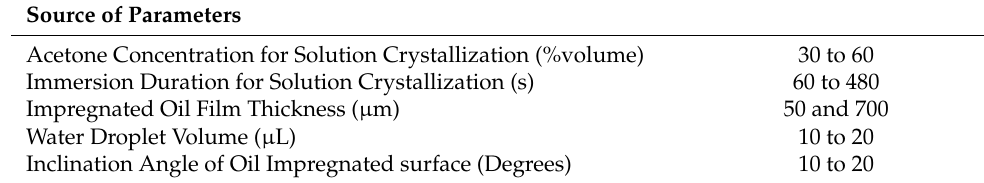
Table 1. Parameters used in solution crystallization and dust mitigation from oil impregnated surfaces. In the experiments, four concentrations of acetone solution and four levels of immersion are considered during crystallization of polycarbonate surface. The acetone concentration and immersion duration maximizing water contact angle (132 ◦ ± 4 ◦ ) are selected, which are 30% acetone concentration 4 min of immersion